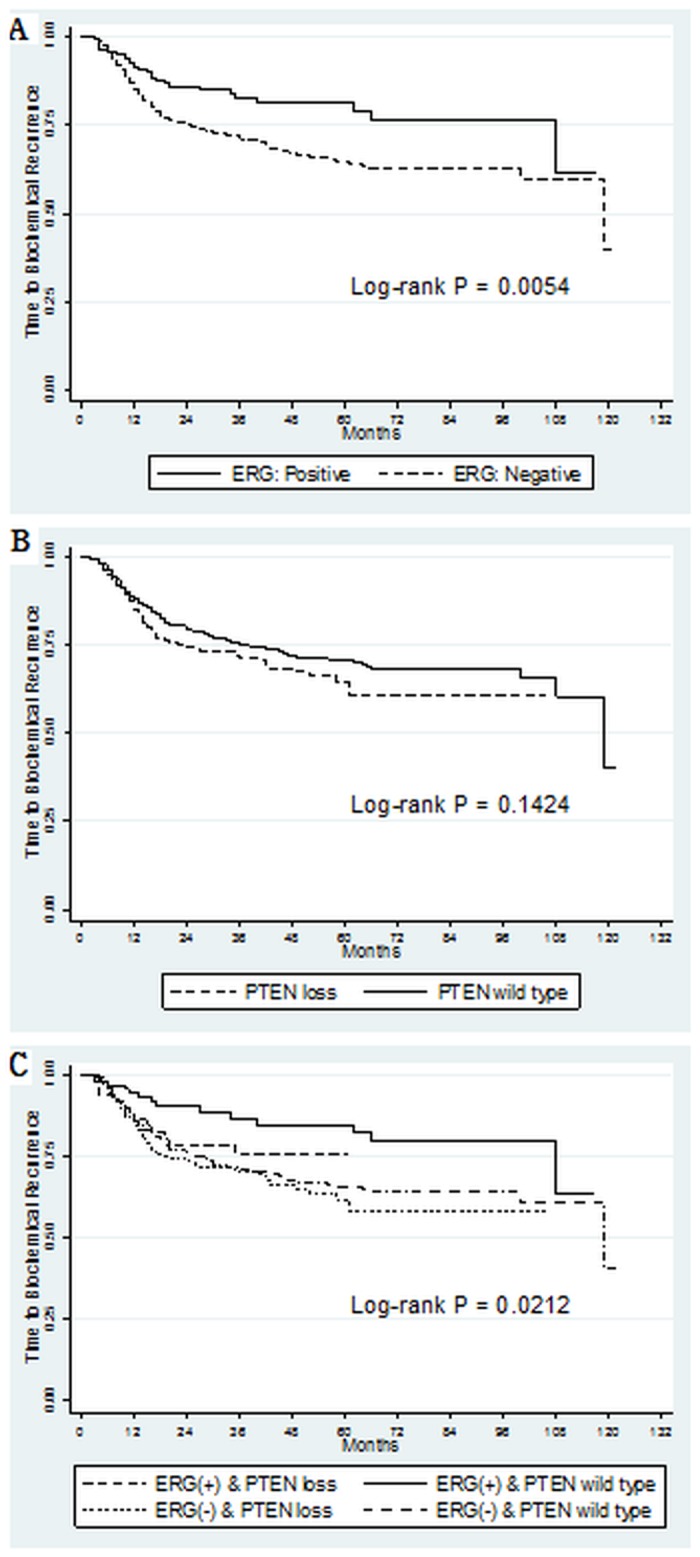
Biochemical recurrence free survival curve according to expression of ERG and PTEN.